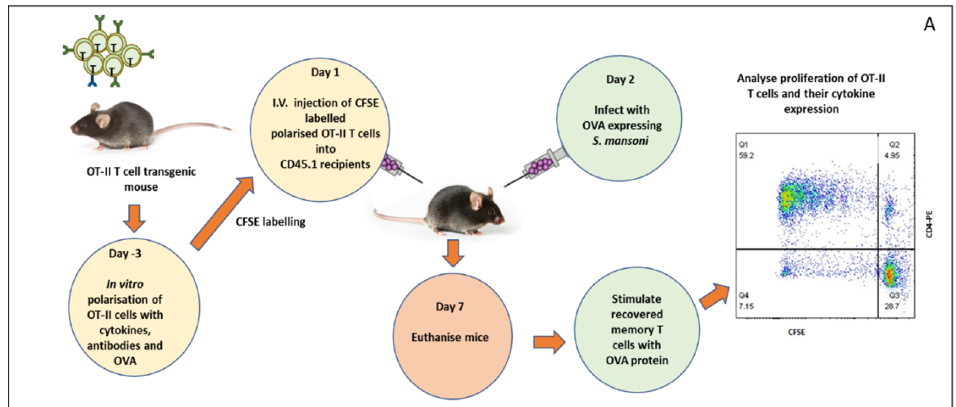
Figure 3. Adoptive transfer of Naïve, Th1, Th2, and Th17 cells and measuring proliferation rate in vivo. This figure depicts the proportion of naïve, Th1, Th2, Th17 cells following a challenge with either OVA protein at a concentration of 30 μ g/mL or OVA-expressing eggs or wild type eggs at a concentration of 1000 eggs in both conditions. After a total of seven days, recipient mice were culled to recover memory cells from spleen and other lymph nodes and the proliferation of the cells was analysed directly based on the initial staining with CFSE and surface staining using specific CD4 markers after recovery and finally followed by a cytometry analysis to quantify the proliferation rate. The abbreviation naïve, Th1, Th2, and Th17 followed by words such as OVA, egg, and Tegg represents an initial injection of the cells into recipient mice and later challenged by the antigens, OVA protein, untransduced eggs, OVA expressing eggs, respectively. Single * ( p < 0.05) and double ** ( p < 0.01) in the graph represents the value of statistical association among the dependent and independent variables and “ns” represents no statistical significance. The experiment in this study were performed in triplicates and the statistical association between different dependent and independent variables was analysed using t -test. The proportion (%) in the Y -axis represents the total number of proliferated T helper cells following antigen stimulation for each type of cells injected into the mouse and a challenge of that mouse with the different antigens ( X